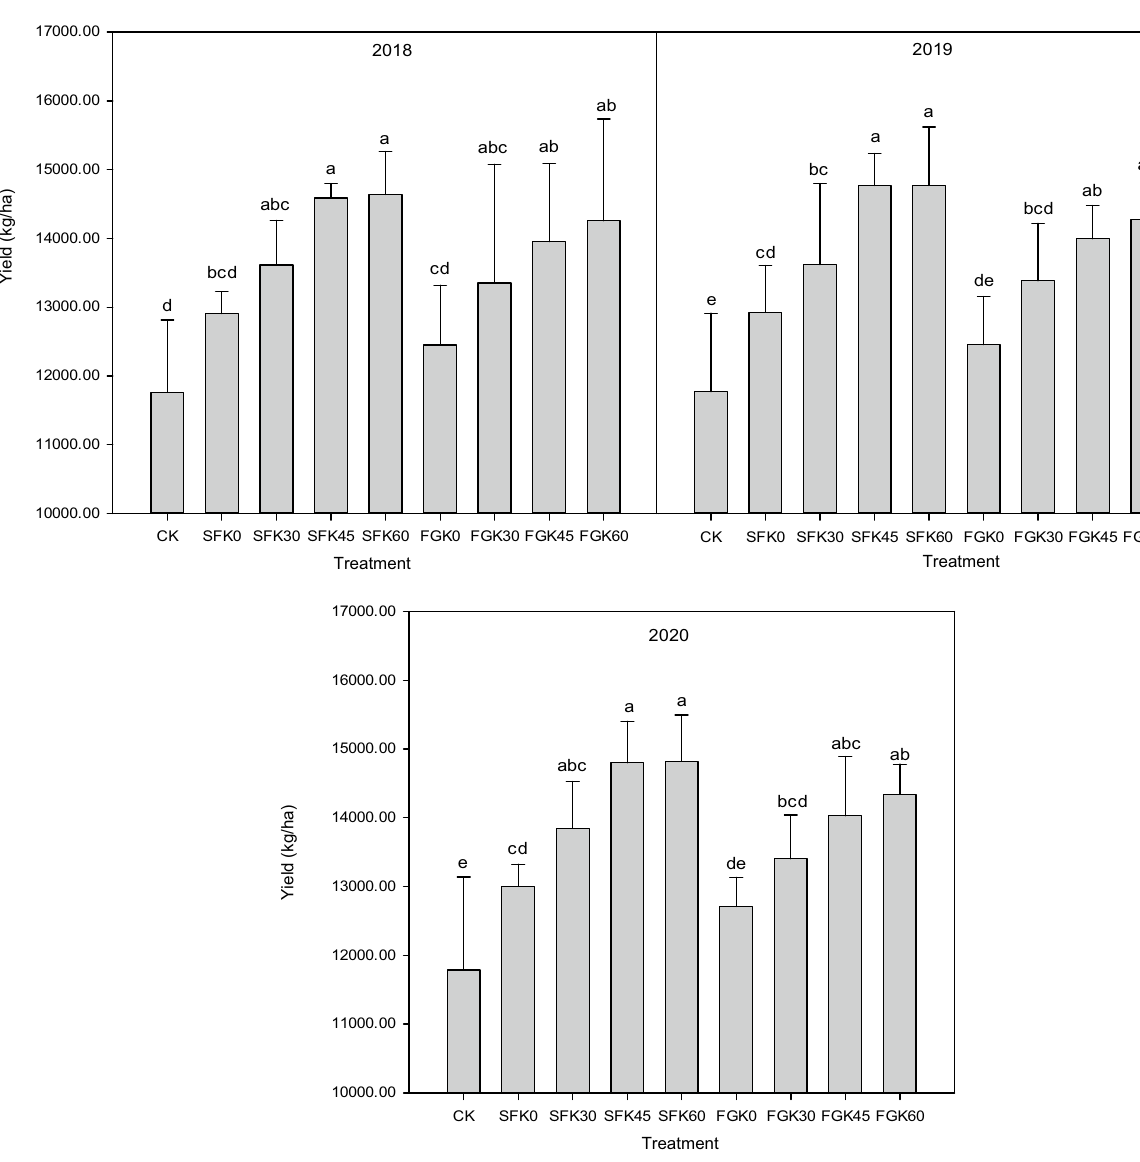
Figure 3. Effects of straw return methods and potassium fertilization levels on maize